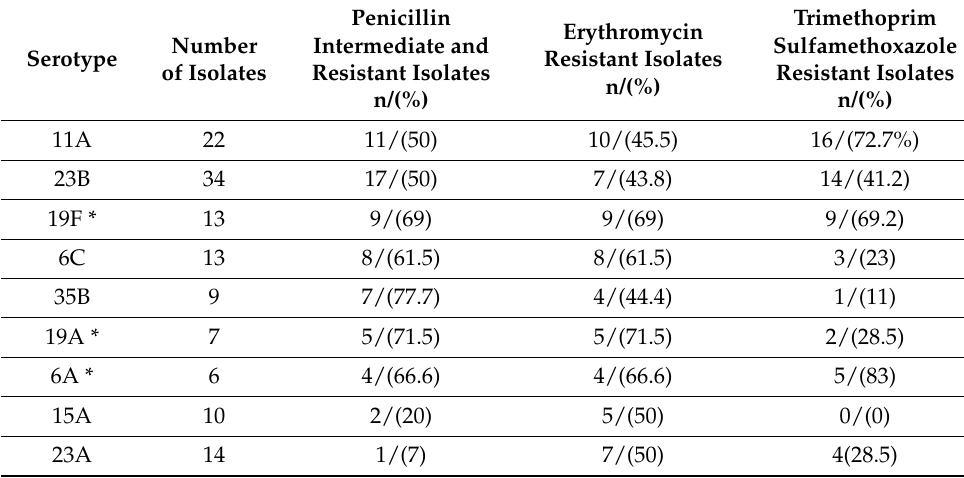
Table 4 show the highest resistant serotypes among the most frequent serotypes. The non-vaccine serotypes 23B (17/34), 11A (11/22), 35B (7/9), and 6C (8/13) and the 13 PVC-specific serotypes 19F (9/13), 19A (5/7), 6A (4/6), and 23F (3/4) were resistant to penicillin. The 65% of the VSs versus 31% of the NVSs were resistant to penicillin ( p < 0.001). Table 4. Resistance rates to penicillin, erythromycin, and trimethoprim sulfamethoxazole among the most frequent